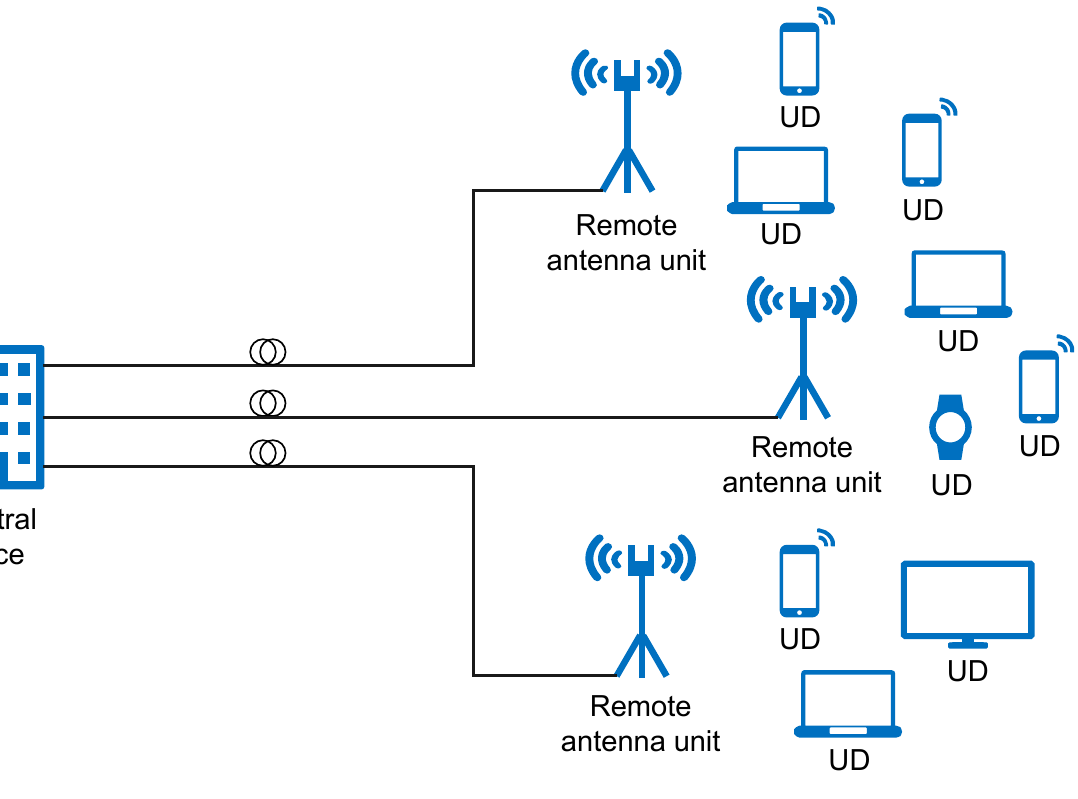
Figure 7. RoF DAS Figure 7. RoF DAS architecture.